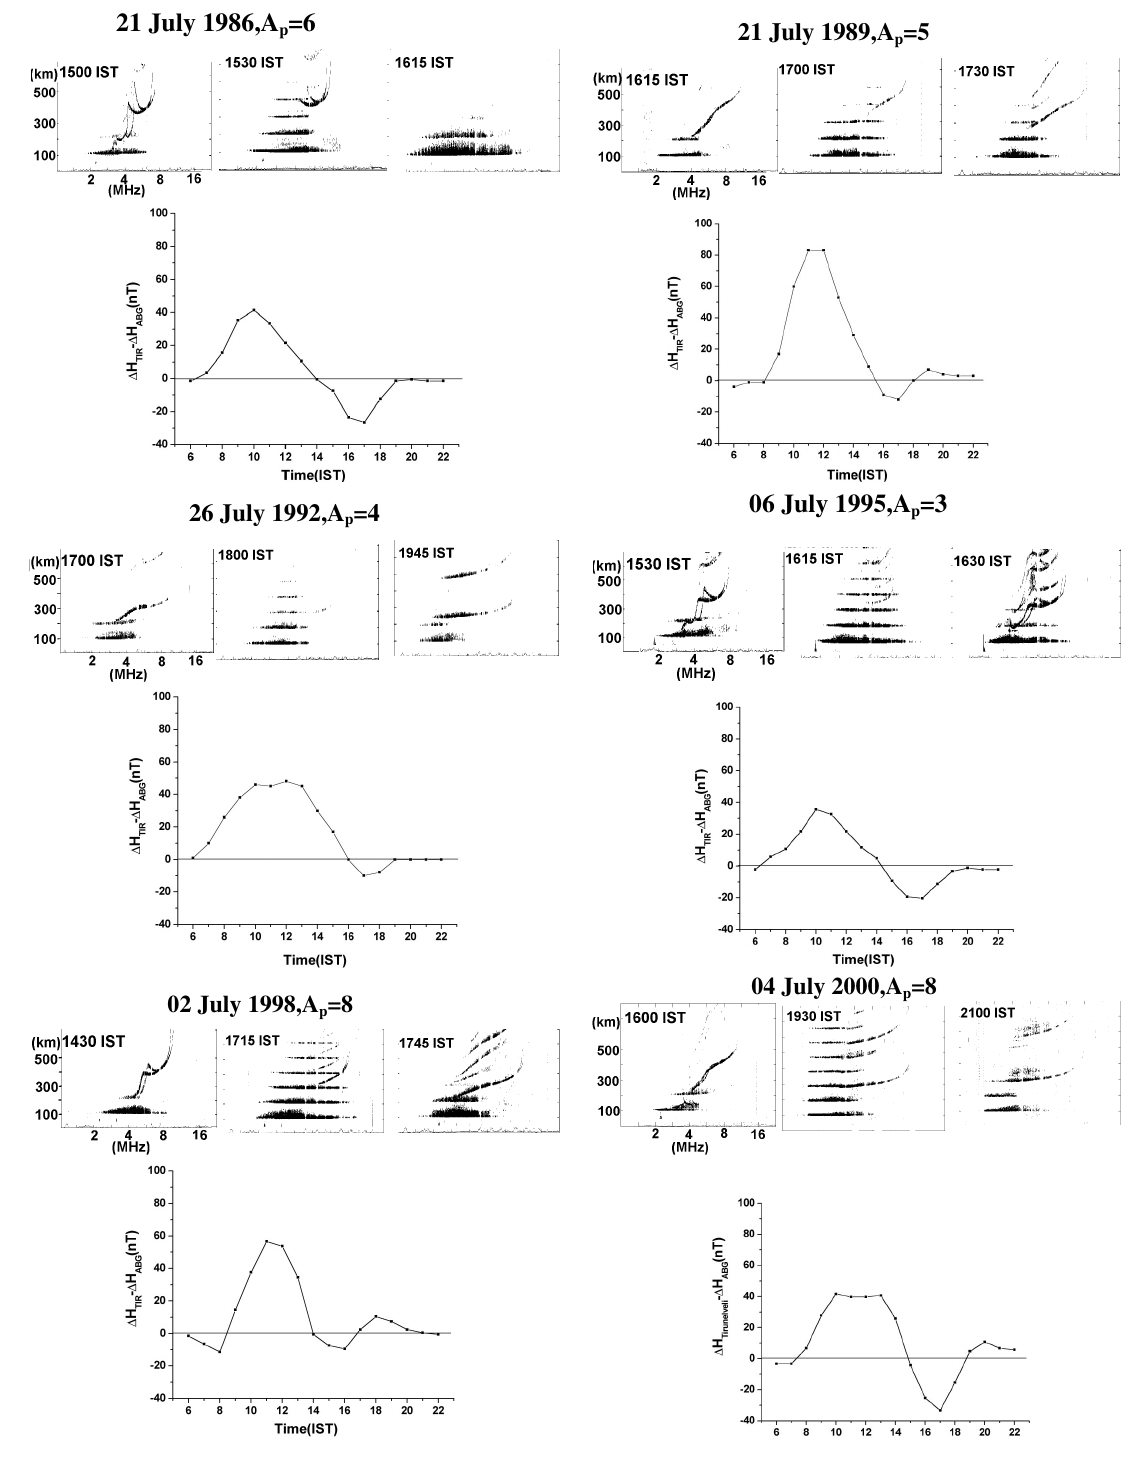
Fig. 4. Some illustrative cases of E sb events during different phases of the solar cycle. Events occurring only on very magnetically quiet days with Ap ≤ 10 are